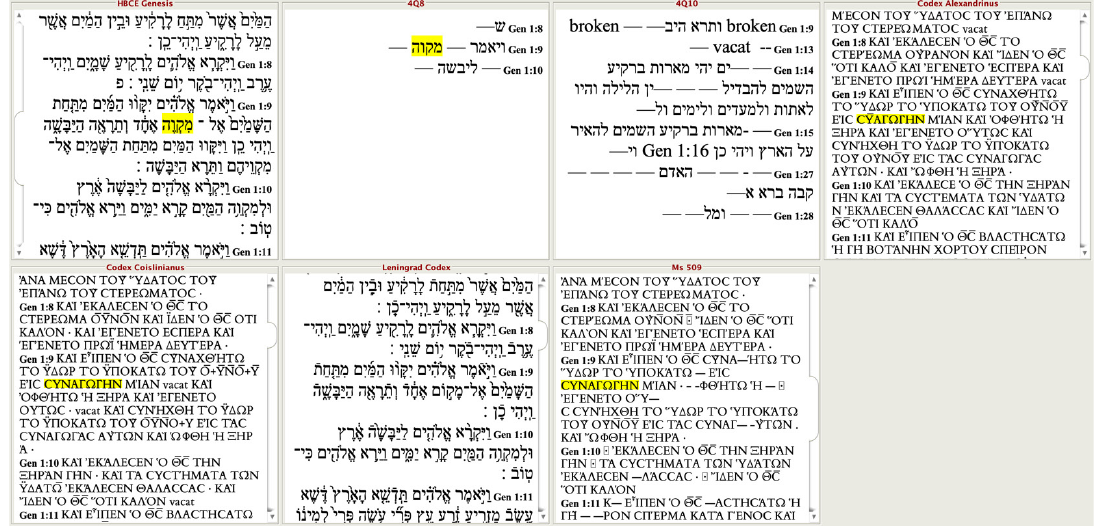
Figure 15: Comparison across languages with equivalent terms